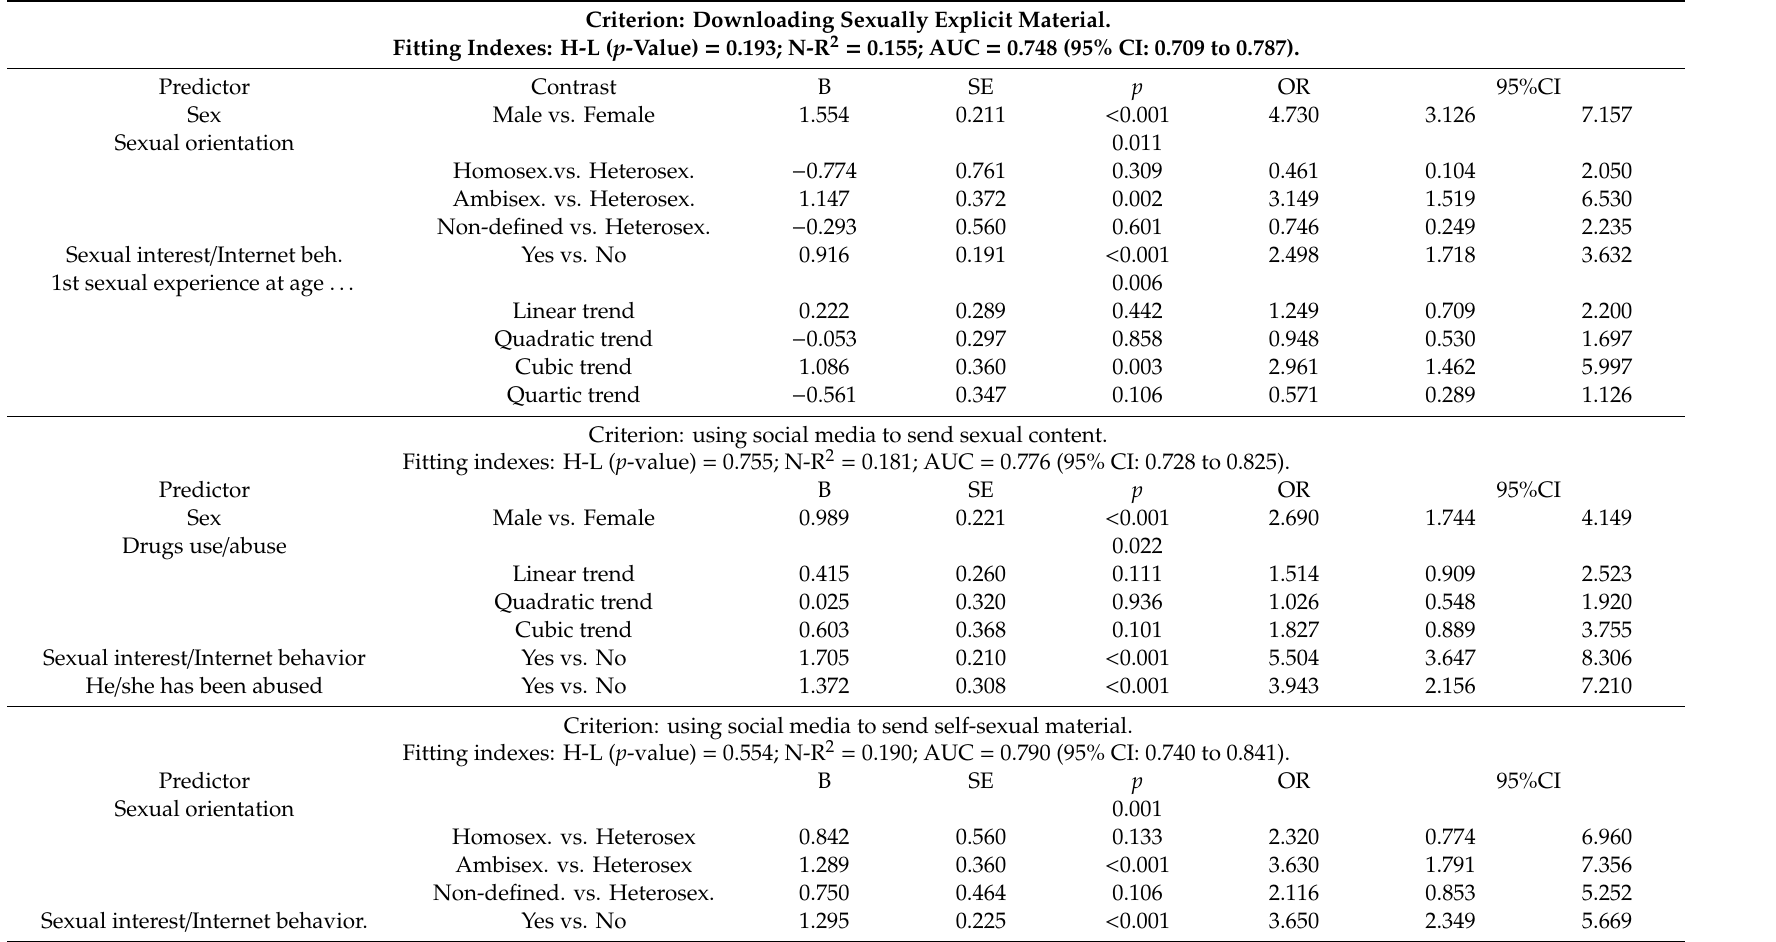
Table 3. Predictive models of pornography use and cybersex behaviors: stepwise logistic regression ( n = 1500). Criterion: Downloading Sexually Explicit